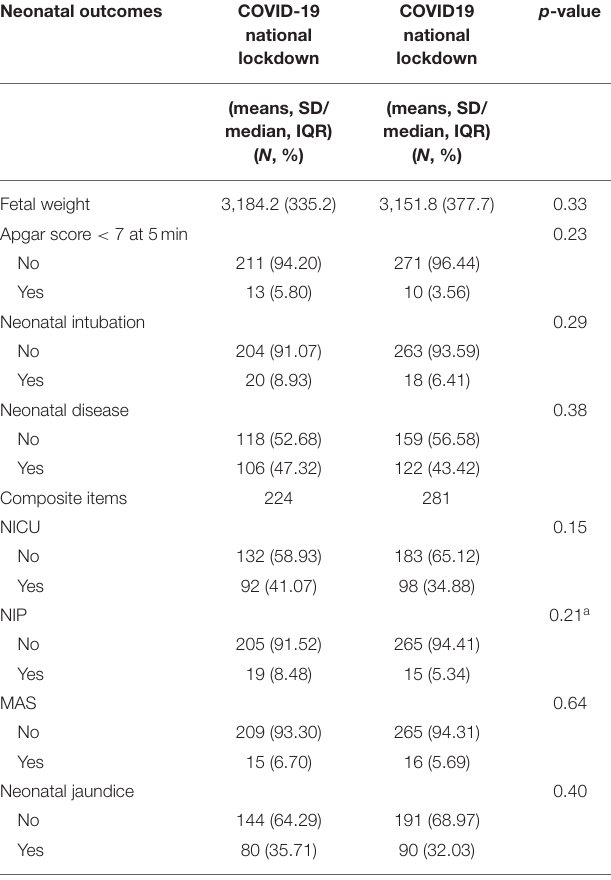
TABLE 2 | Adverse term neonatal outcomes between COVID-19 national and regional lockdown periods. Neonatal